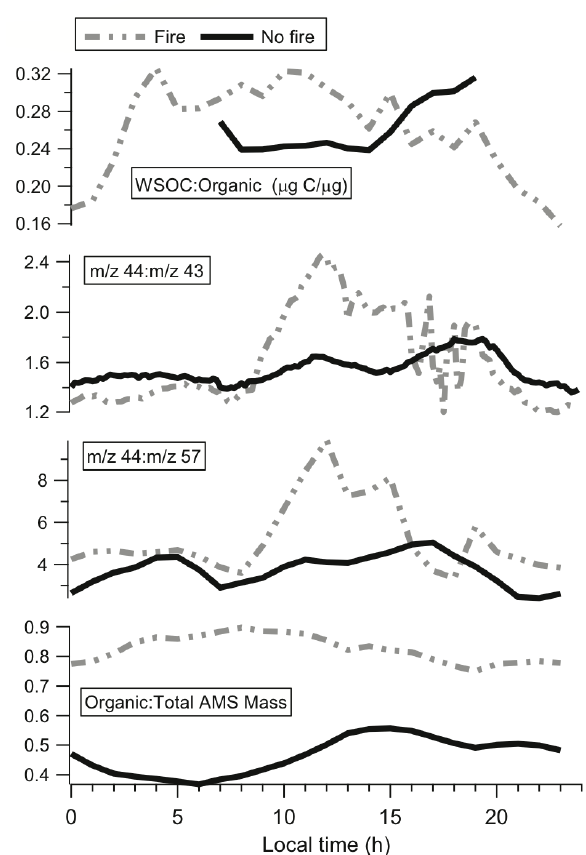
Fig. 5. Diurnally averaged ratios of different organic aerosol mea- surements during the fire and non-fire